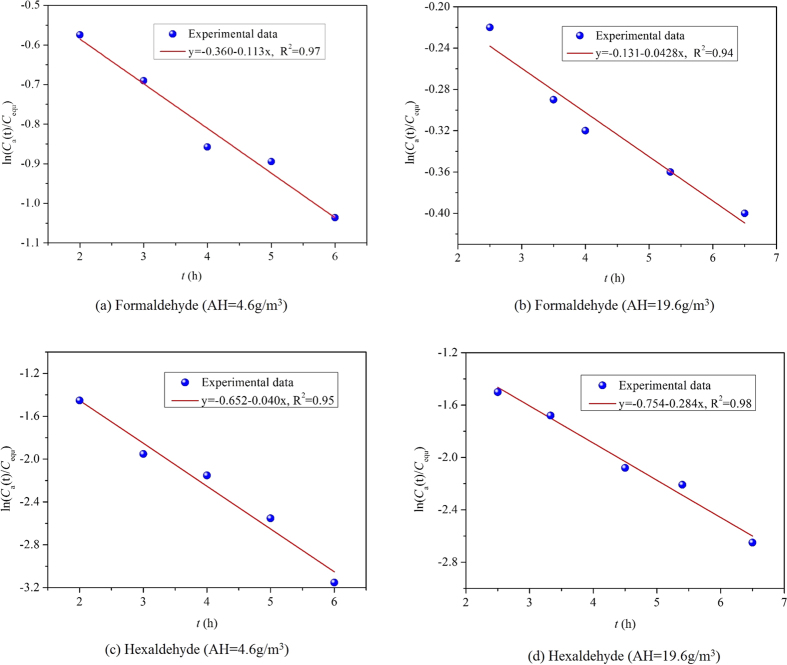
Linear relationship between ln(Ca/Cequ) and time at AH of 4.6 g/m3 and 19.6 g/m3 by fitting the experimental data.